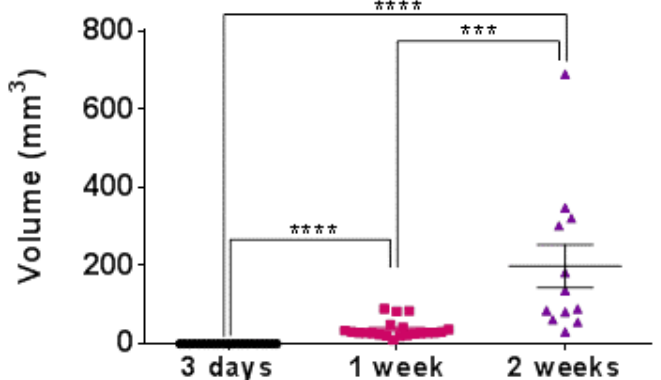
Figure 2. Tumor volumes were measured at 3 days, 1 week, and 2 weeks after 4T1 cell inoculation (**** p < 0.0001, *** p = 0.0005, unpaired Student t -test). Note: The volume was considered zero at the 3-day time point due to the undetectable volume at the cell injection site.